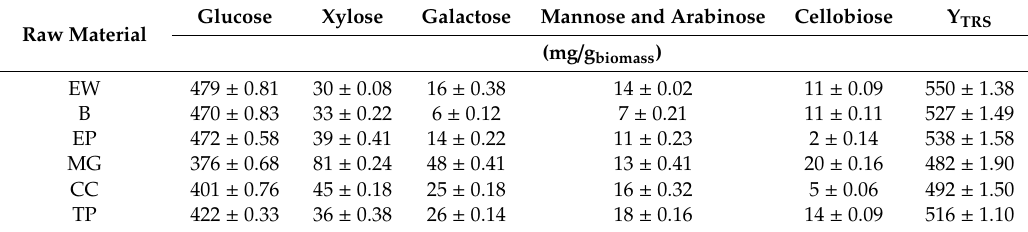
Table 4. Content of selected carbohydrates in enzymatic hydrolysates of six di ff erent pre-treated lignocellulosic